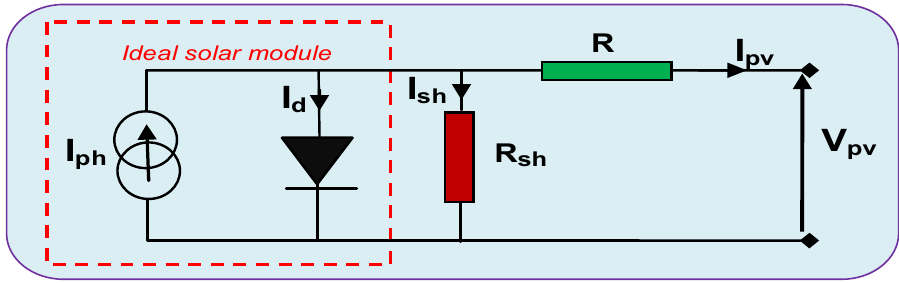
Figure 2. Equivalent circuit of solar module.